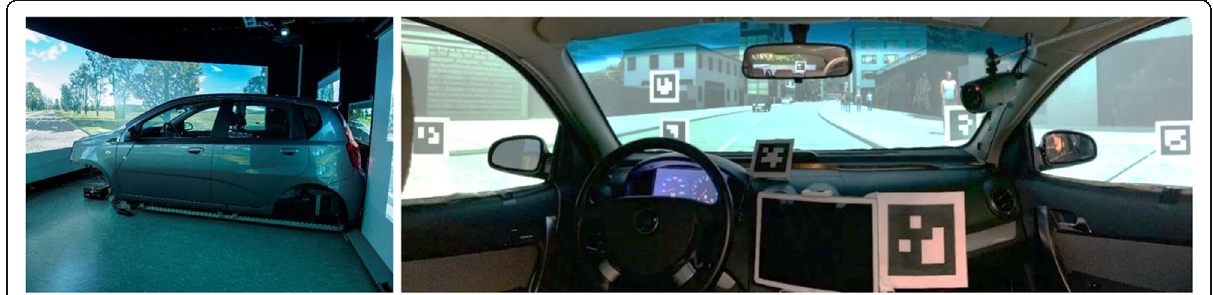
Fig. 2 Left: Exterior view of the static driving simulator at the Institute of Ergonomics & Human Factors at the TU Darmstadt; Right: View of the vehicle